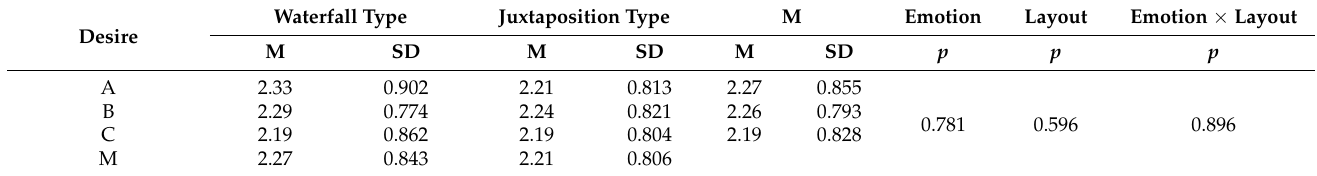
Table 7. Descriptive statistics and two-way ANOVA for desire for similar lessons.